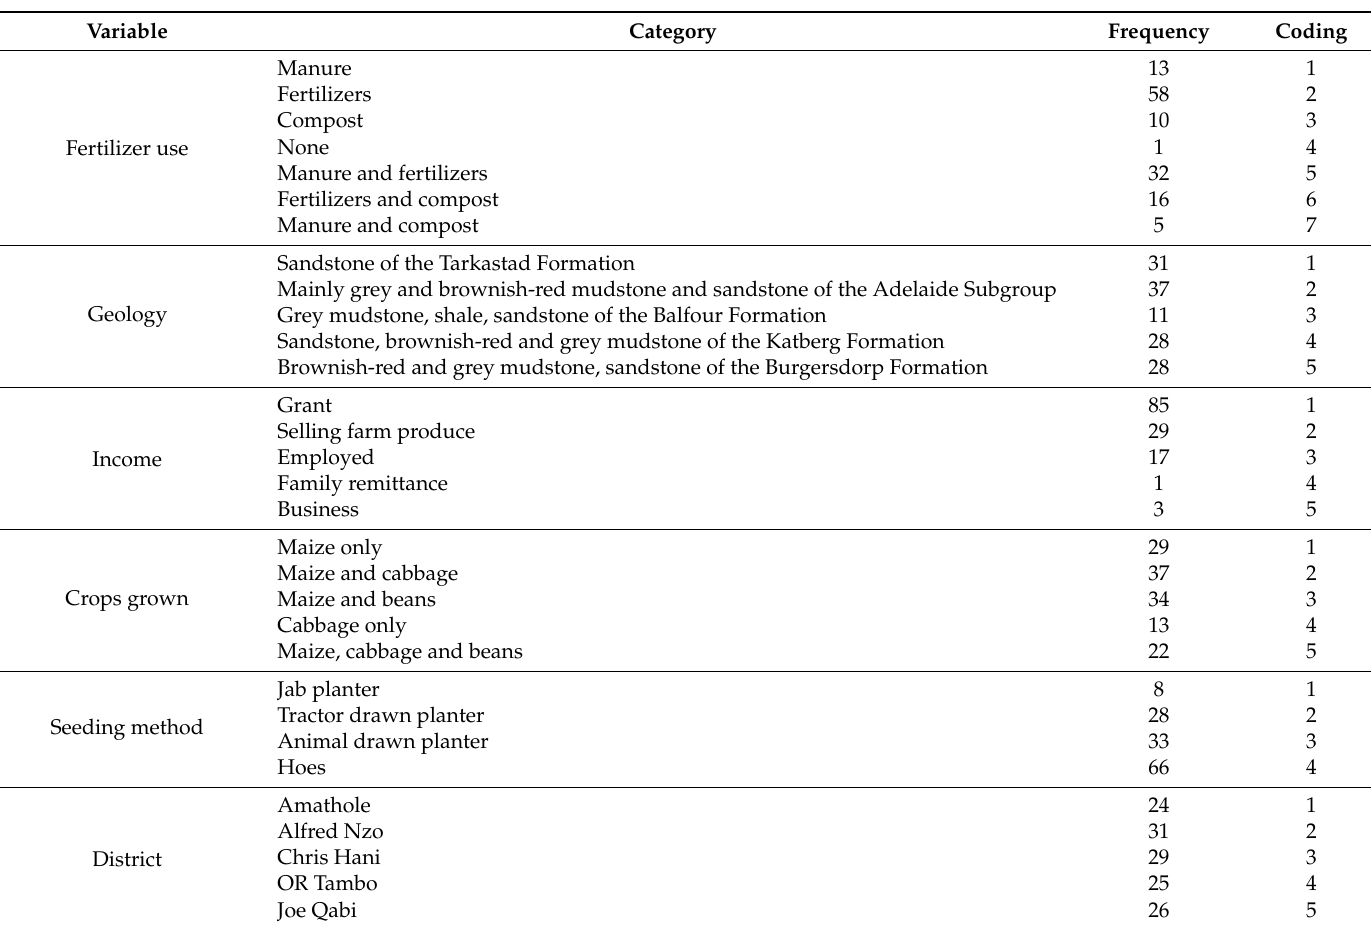
Table A1. Predictor variables and coding used in the binary logistic